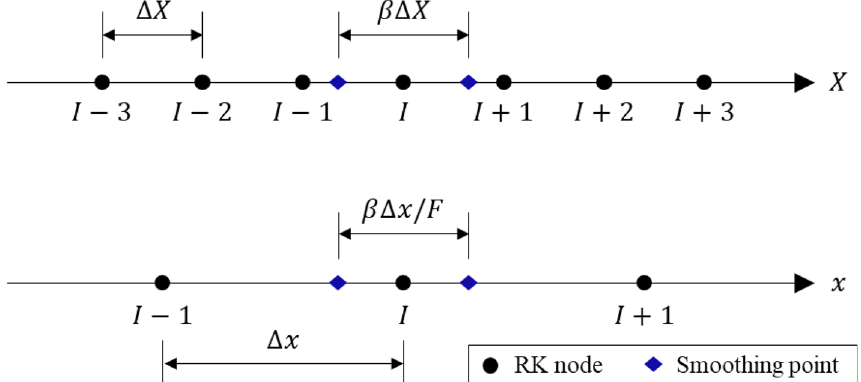
Fig. 25 Illustration of nodes and the smoothing point of node I in the reference and current